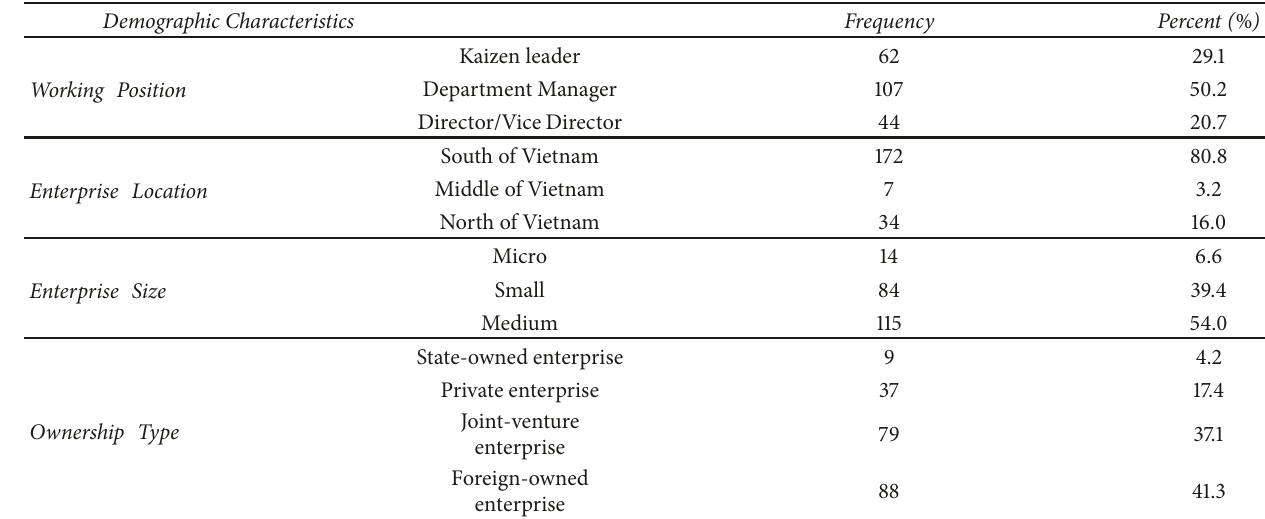
Table 3: Descriptive statistics of